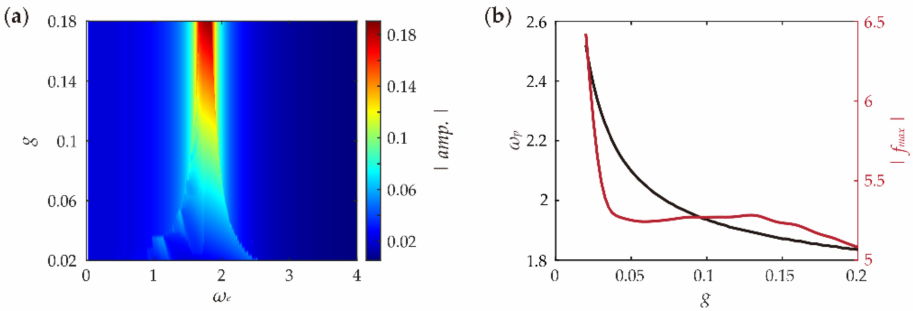
Figure 11. Effects of constraint gap on ( a ) the frequency responses of the resonant-impact DEA system and ( b ) the peak frequency and peak impact